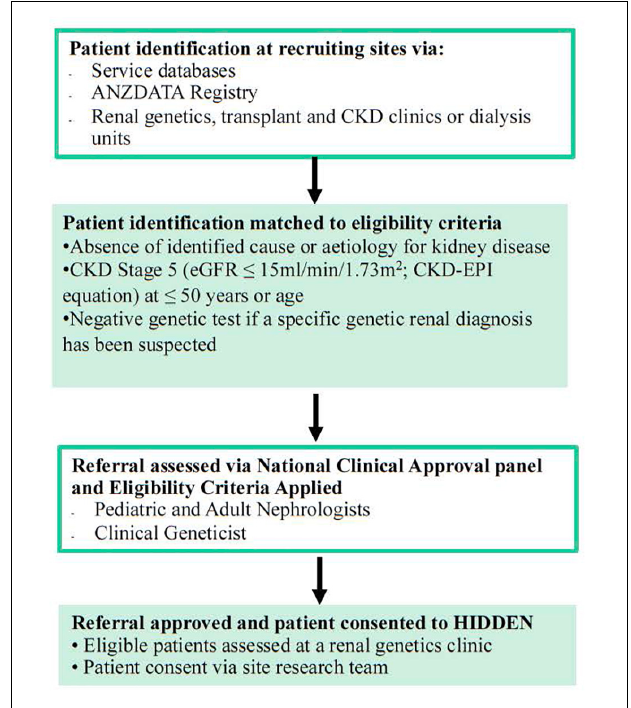
FIGURE 1 | Recruitment flow into